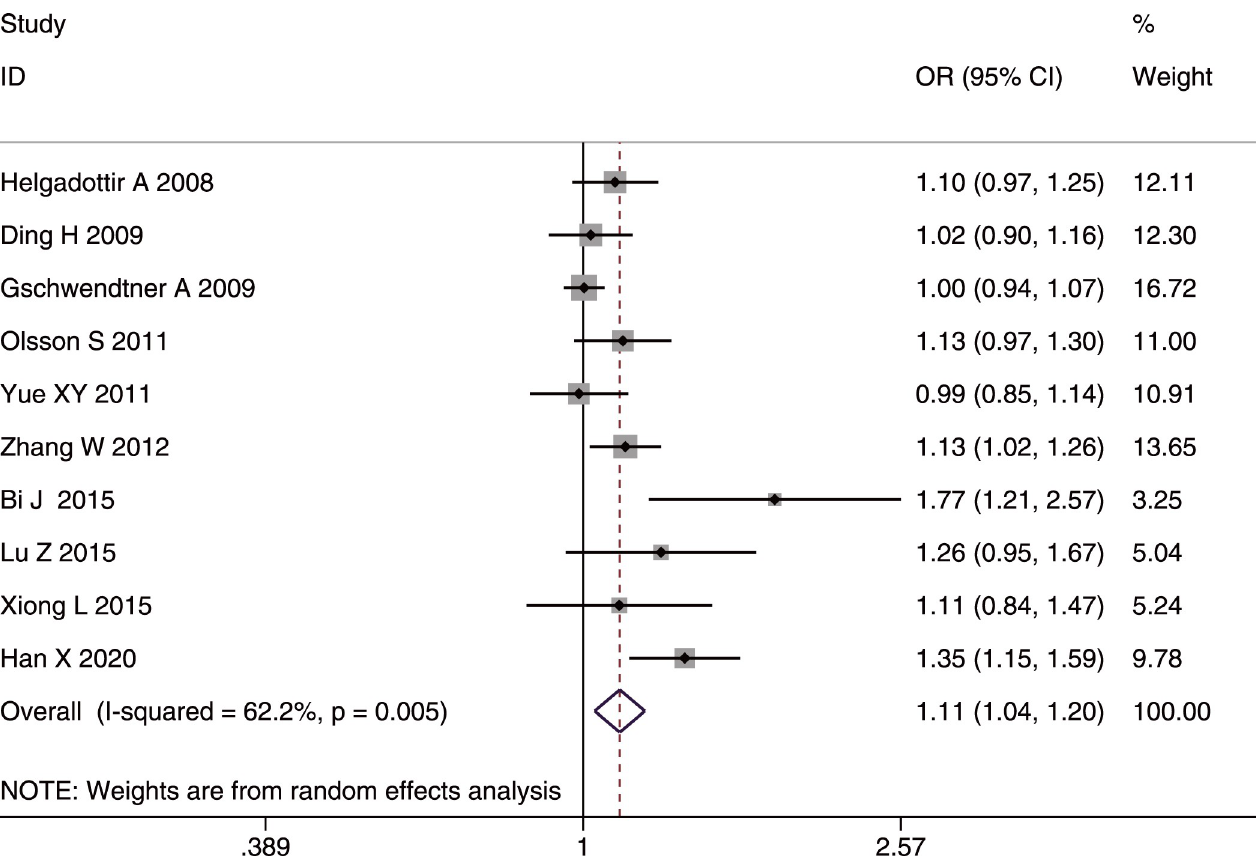
PLOS ONE | https://doi.org/10.1371/journal.pone.0263459 June 2,